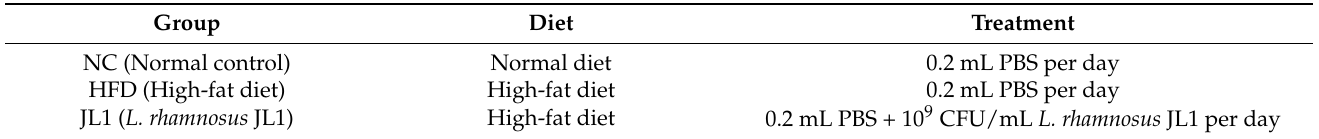
Table 1. Treatment for Experimental mice.